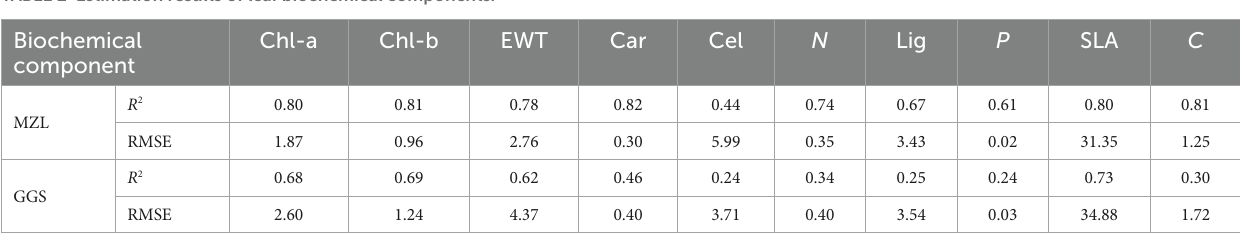
TABLE 2 Estimation results of leaf biochemical